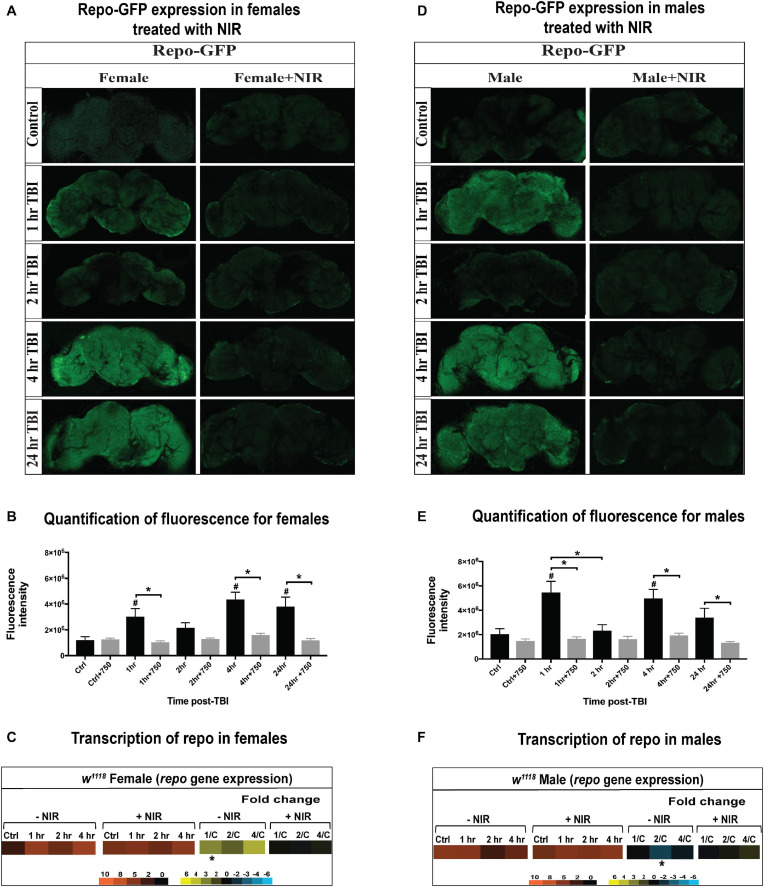
GFP-tagged repo expression in w1118 male and female flies. Confocal images showing change in GFP expression in Repo-GFP flies at control, 1, 2, 4, and 24 hr after TBI in females (A) and males (D) with and without exposure to NIR. About 10–15 brains were imaged for each condition and representative images from each group are shown here. Average fluorescence intensity for each time-point (10–15 brains) was assessed using ImageJ marking whole brain area as region of interest (B,E). A significant increase (One-way ANOVA, Dunnett test, p-value < 0.05) in GFP expression was observed for both sexes at 1, 4, and 24 hr after injury. GFP expression was unchanged in both sexes inflicted with TBI after NIR exposure. Repo transcription was significantly upregulated (| log2FC| > 1, p-value < 0.05) in females 1 hr after injury (C) and downregulated in males (F) 2 hr after injury. NIR exposure had no change in repo transcription in both sexes.